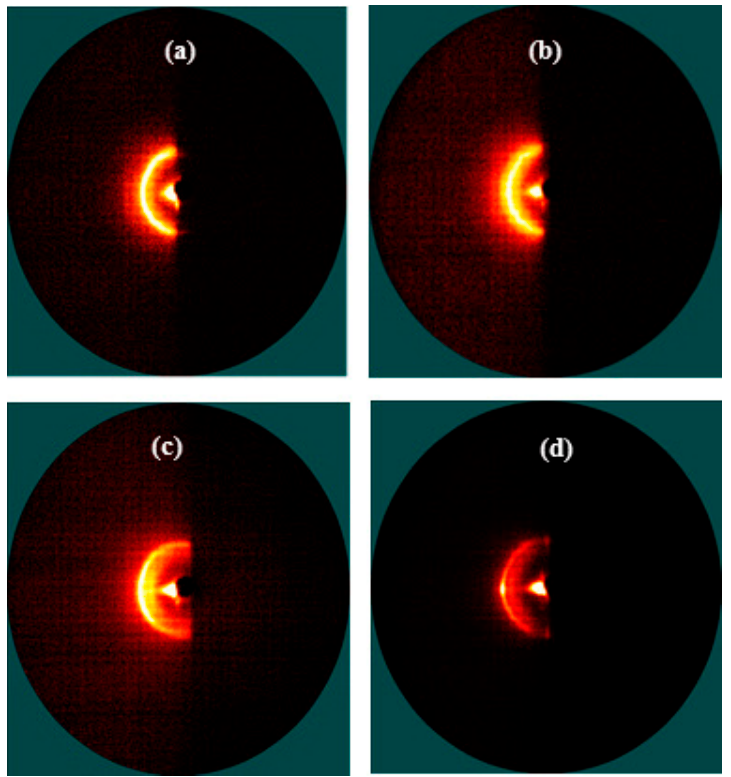
Figure 4. Debye ring pattern of CP40 (samples ( a – d )) after the thermal treatment with different con-